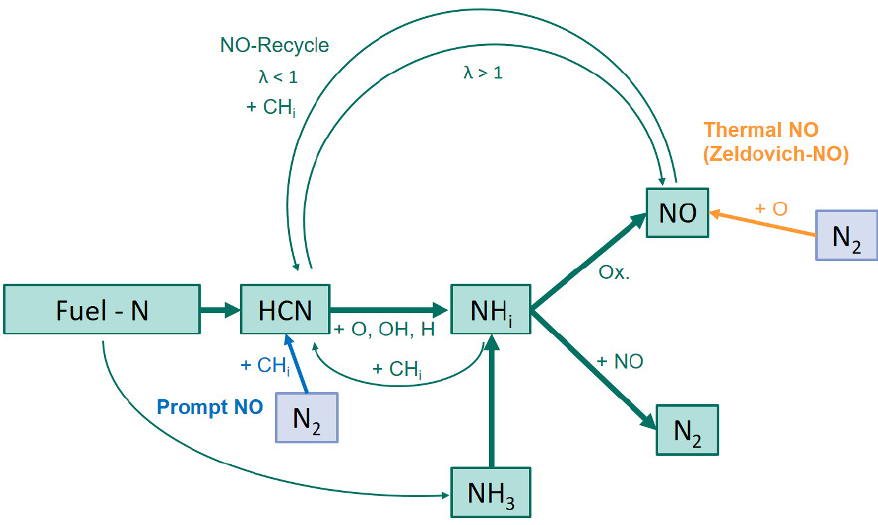
Figure 1. NO formation mechanisms [8].